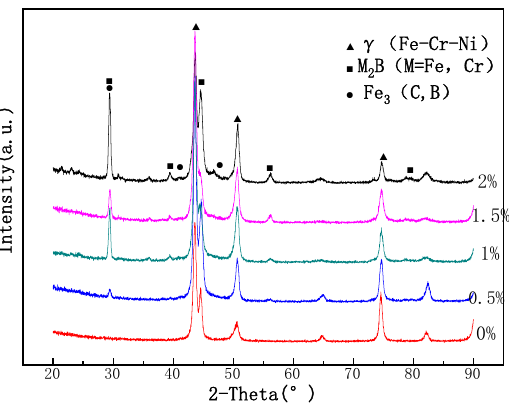
Figure 2. X-ray diffraction comparative analysis of different boron content in surfacing alloy. The austenite grain size with different boron content is obtained by Jade’s treatment of the diffraction curve with the Scheler formula shown in Formula 3, as shown in Table 3. The grain size of boron free austenite is 180 ± 3 nm. Boride is formed with the addition of boron, and the formation temperature of boride is higher. During the cooling process of the molten pool, with boride as the core, austenite begins to nucleate, as shown in Figure 3. With the increase of B content, the compound formed with Fe element in the steel pinned the grain boundary, which strongly hindered the grain growth, and when B was 2%, the refinement effect of the structure was the best. The grain size of austenite is 119 ± 2.8 nm.